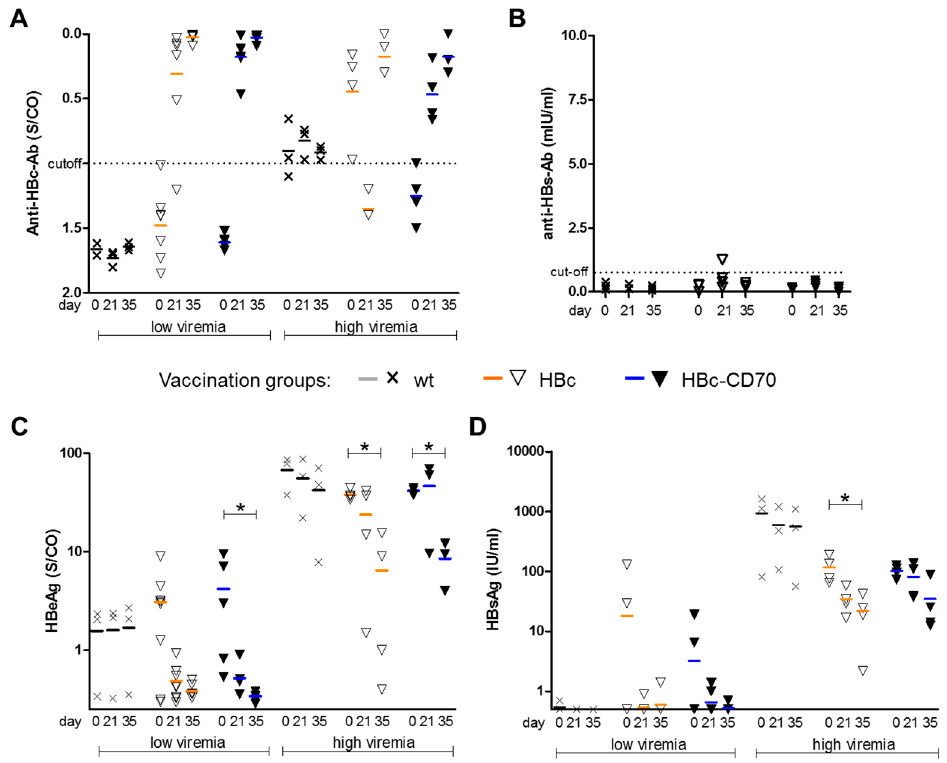
Figure 3. Development of HBV-specific antibodies and reduction in serum HBV antigens in HBV1.3tg mice receiving a protein-prime/MVA-boost vaccination. Serological markers were determined prior to the protein prime (day 0), after two protein vaccinations prior to the MVA boost (day 21) and seven days after the MVA boost (day 35). ( A ) Prior to vaccination, the mice were divided into groups that had either low/intermediate HBeAg levels (1-8 S/CO) or high antigen levels (>8 S/CO). ( A , B ) HBcAg-specific antibodies (anti-HBc) in these two groups of mice ( A ) and HBsAg-specific antibodies (anti-HBs) determined in low-viremic mice. ( C , D ) Serum HBeAg ( C ) and HBsAg ( D ) levels in low and high-viremic vaccinated mice. Crosses and triangles represent individual mice; Horizontal lines indicate mean values; Error bars indicate standard deviation. Statistics in ( A ) ( C ) and ( D ) were performed with one-way ANOVA, * p -value < 0.05.